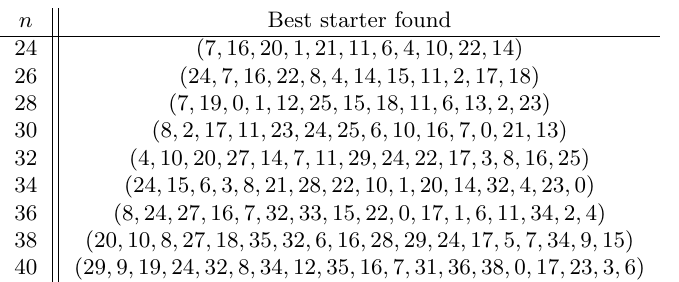
Table 9: The best starters found for round-robin tournaments of orders 24